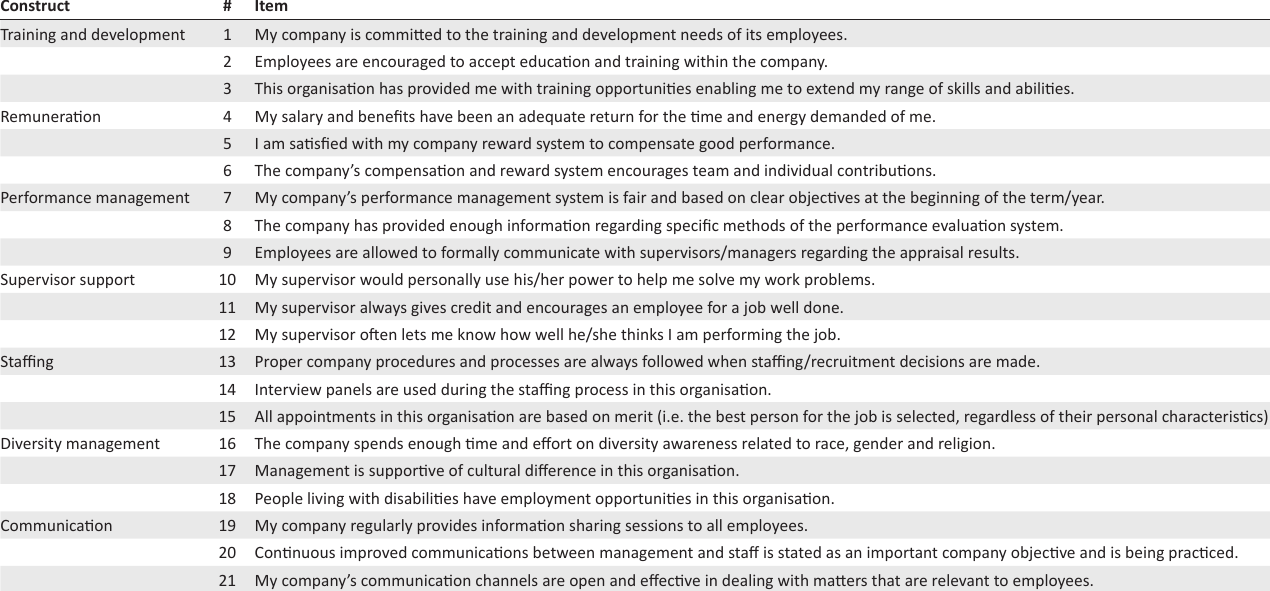
TABLE 1-A1: Constructs and items of the Human Resource Practices Scale.